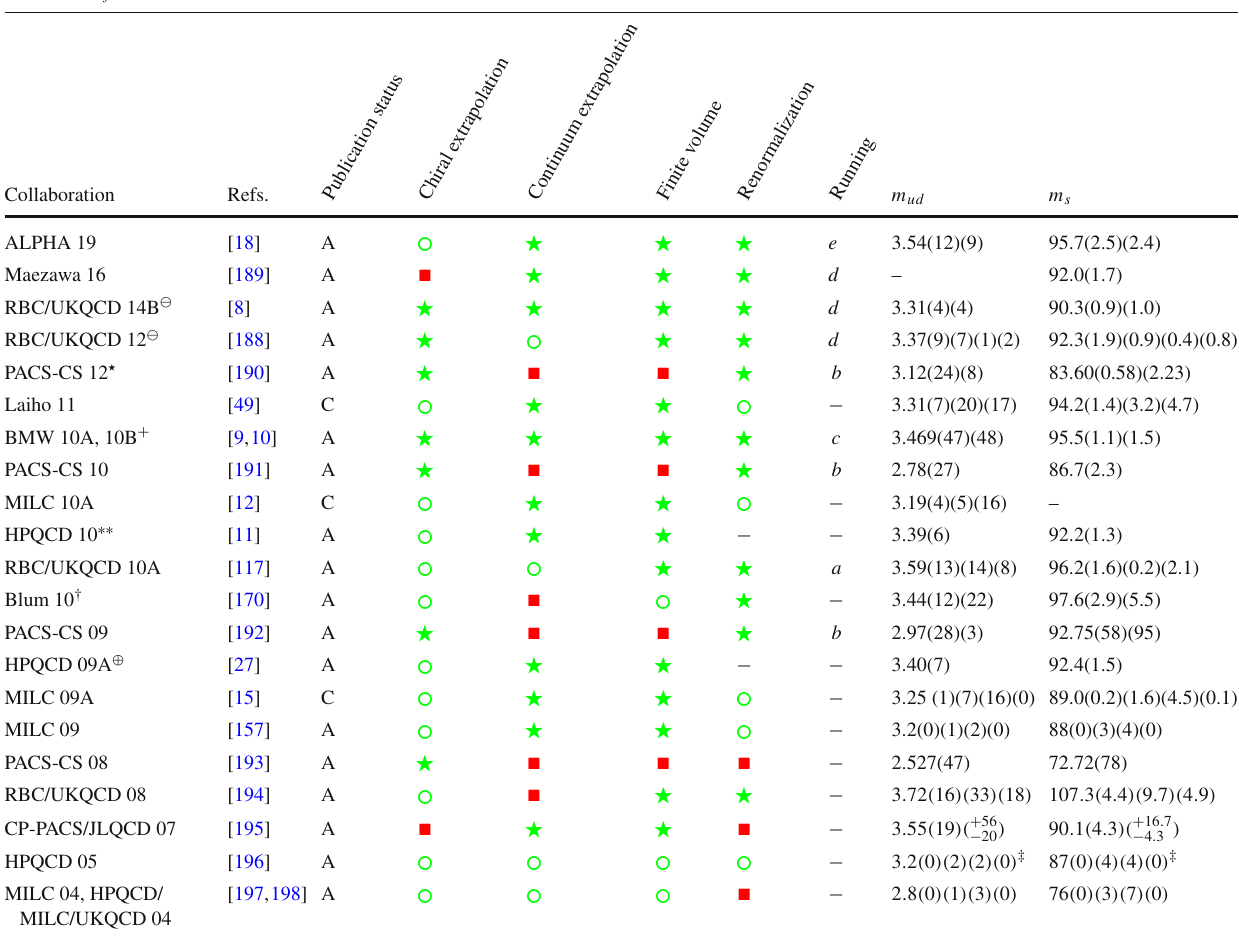
Table 6 N f = 2 + 1 lattice results for the masses m ud and m s (MeV)